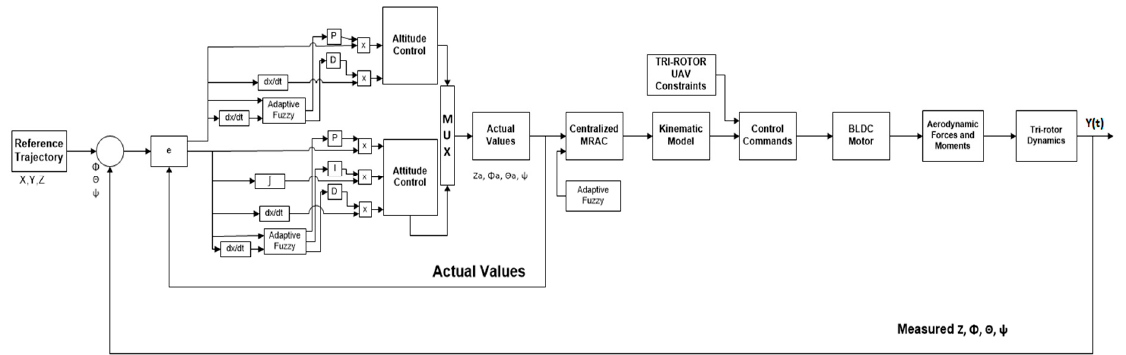
Figure 2. The block diagram of the reference trajectory control system.